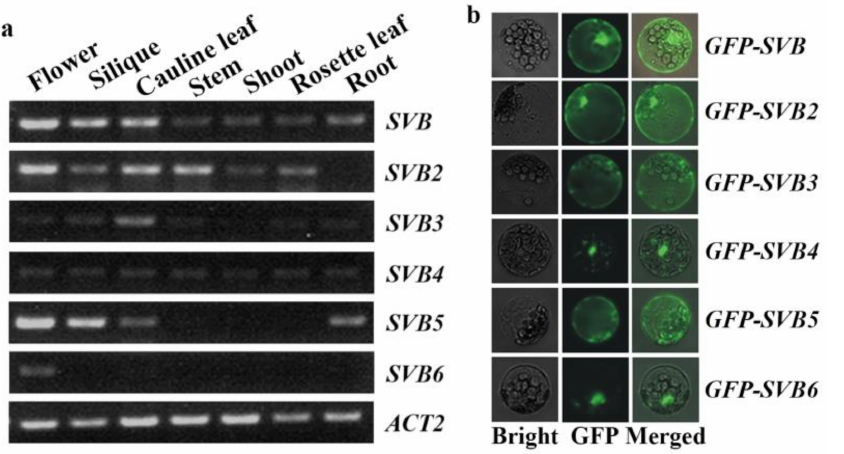
Figure 2. Expression patterns of SVBs and subcellular localization of SVBs. ( a ) Expression pattern of SVBs . RNA was isolated from different tissues and organs collected from the Col wild type Arabidopsis plant, and RT-PCR was used to examine the expression of SVBs . The expression of ACT2 was used as a control. ( b ) Subcellular localization of SVBs. Plasmids of the effector genes GFP-SVBs were transfected into protoplasts isolated from rosette leaves of 3-4 weeks old Col wild type Arabidopsis plants, and GFP fluorescence was observed and photographed under a confocal microscope after the transfected protoplasts were incubated in darkness at room temperature for 20~22